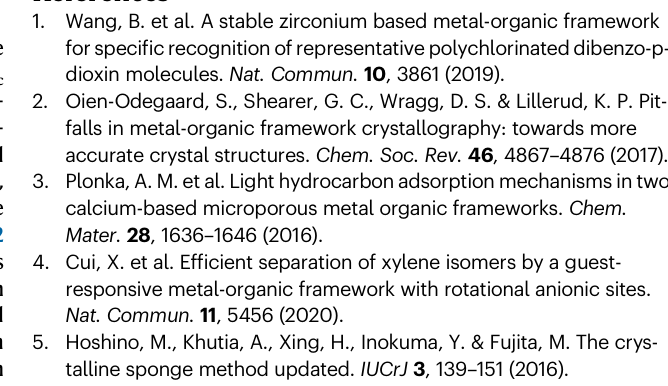
Fig. 2 | The asymmetry unit of BCDD@BUT-17. ORTEP view for the asymmetry unit of BCDD@BUT-17 determined from the newly collected SCXRD data. Dis- placement ellipsoids are represented by 30% probability